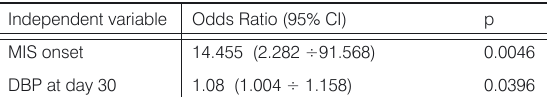
= 0.0015; model C ≈ AU